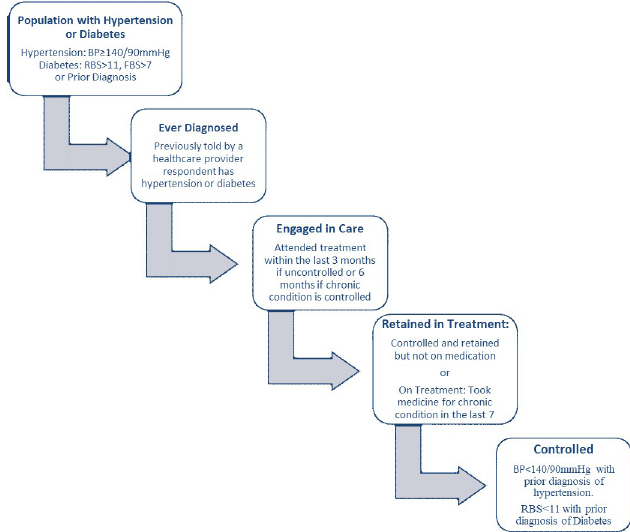
Fig 1. Cascade of care used for hypertension or dabetes. Progressing from the population with the chronic condition, to diagnosis, engagement in care, retained in treatment with either lifestyle or pharmaceutical treatments, and control of the chronic condition. BP, blood pressure; FBS, fasting blood sugar; RBS, random blood sugar.